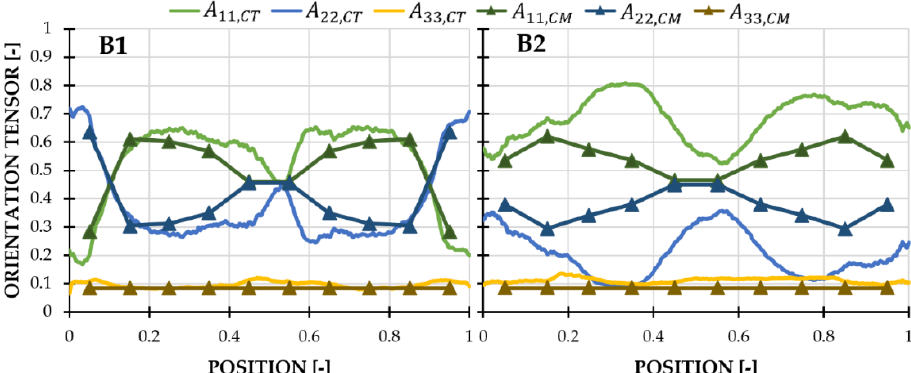
Figure 12. Experimental (CT) and simulative (CM) components of the fiber orientation tensor A ij over normalized position for PPAGF50 at component level (B1–B2) in optimized condition C NC ,2 Table 6. Relative deviation of the averaged orientation tensors from experiment A ij , CT and simulation A ij , CM of PPAGF50 on component level (B1–B2) in optimized condition C NC ,2